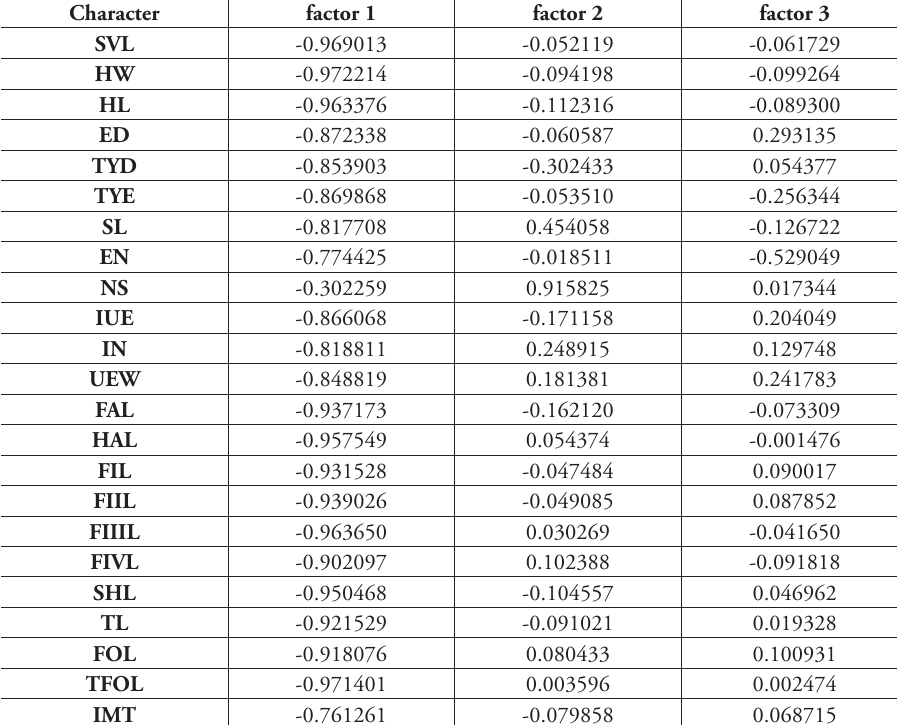
Factor coordinates of the morphometric characters used in PCA analysis, based on correlations (factors 1 to